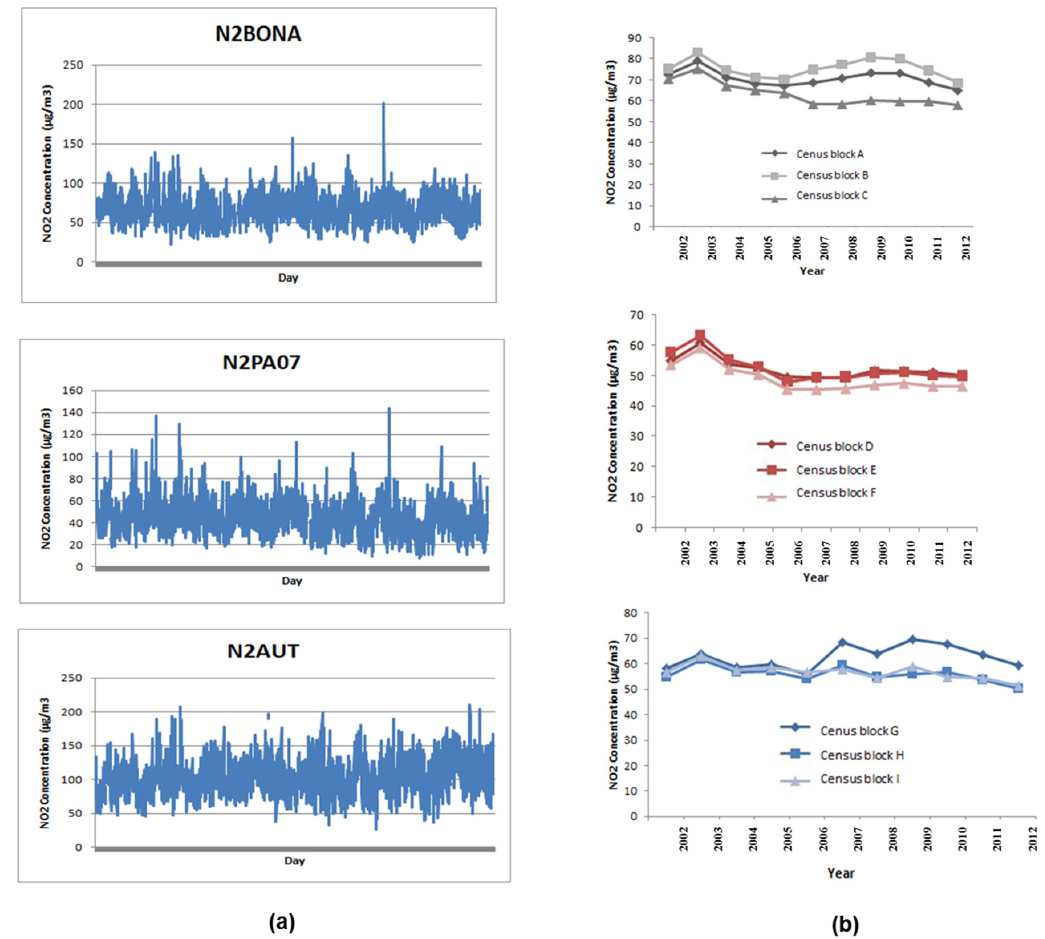
Figure 6. Illustration of time trends during the study period (2002–2012): ( a ) the variability of daily concentrations measured at three monitoring stations named the “index” monitors; ( b ) the variability of annual concentrations estimated for three census blocks among all the census blocks represented by each monitoring station.